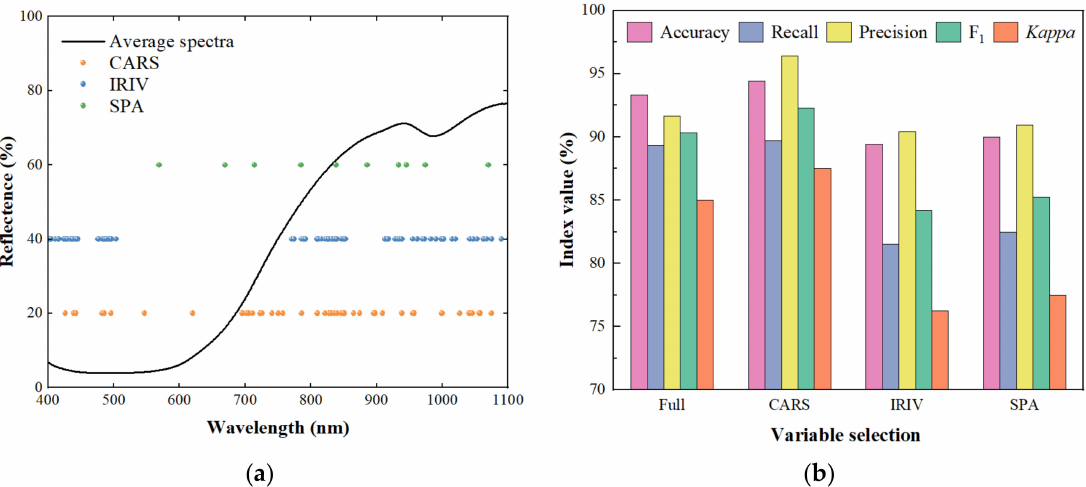
Figure 5. ( a ) Distribution map of feature variables. ( b ) Test set results of SVM model based on these variables.